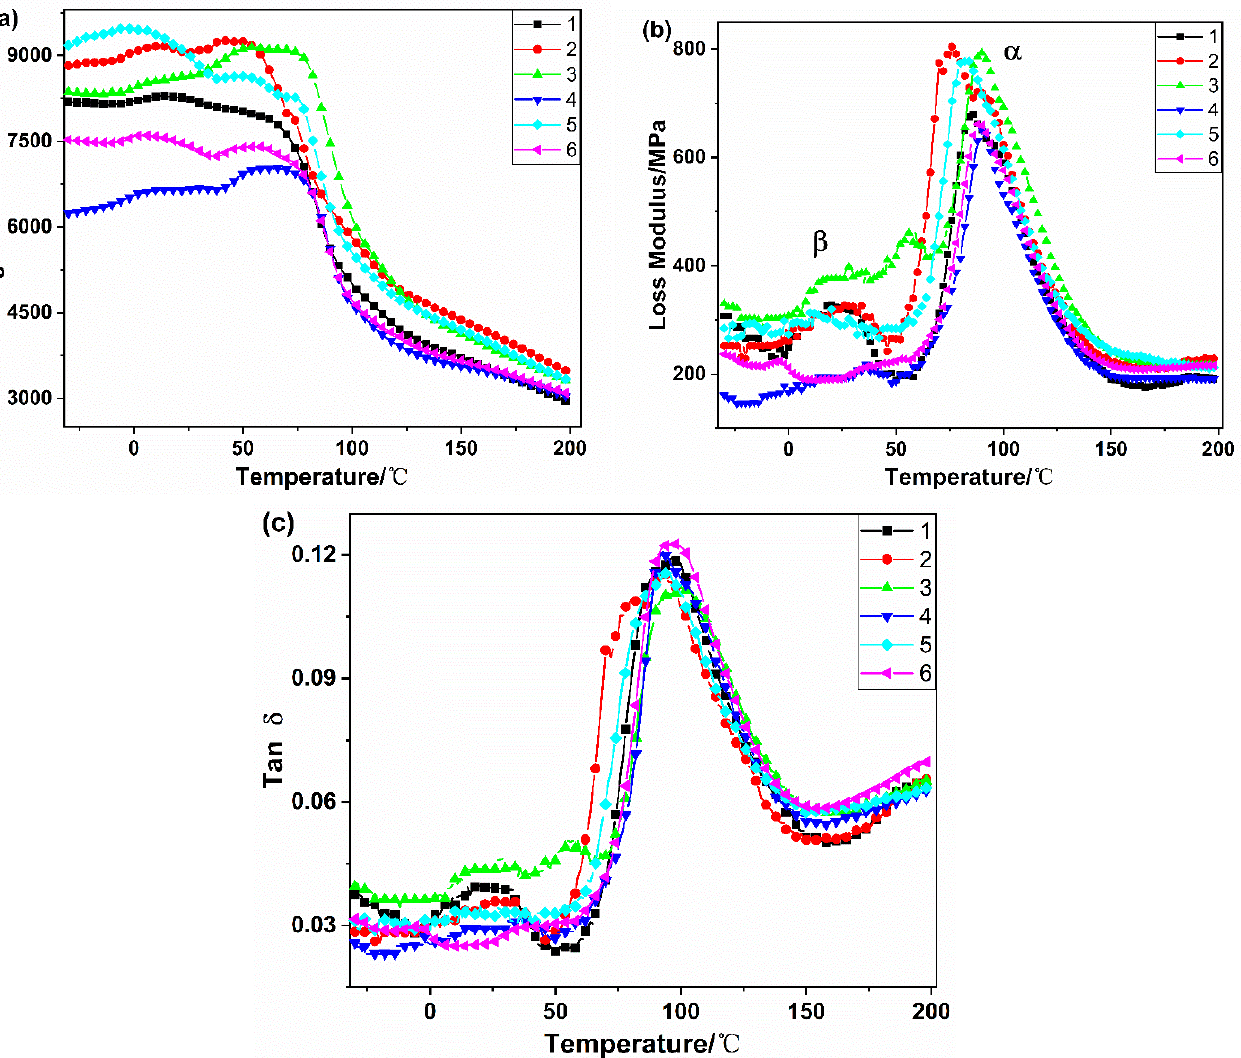
Figure 10. Dynamic thermo-mechanical analysis curve of PA56T/GF ( a ) storage modulus of the PA56T/GF samples; ( b ) loss modulus of the PA56T/GF samples; ( c ) tan δ of the PA56T/GF samples.